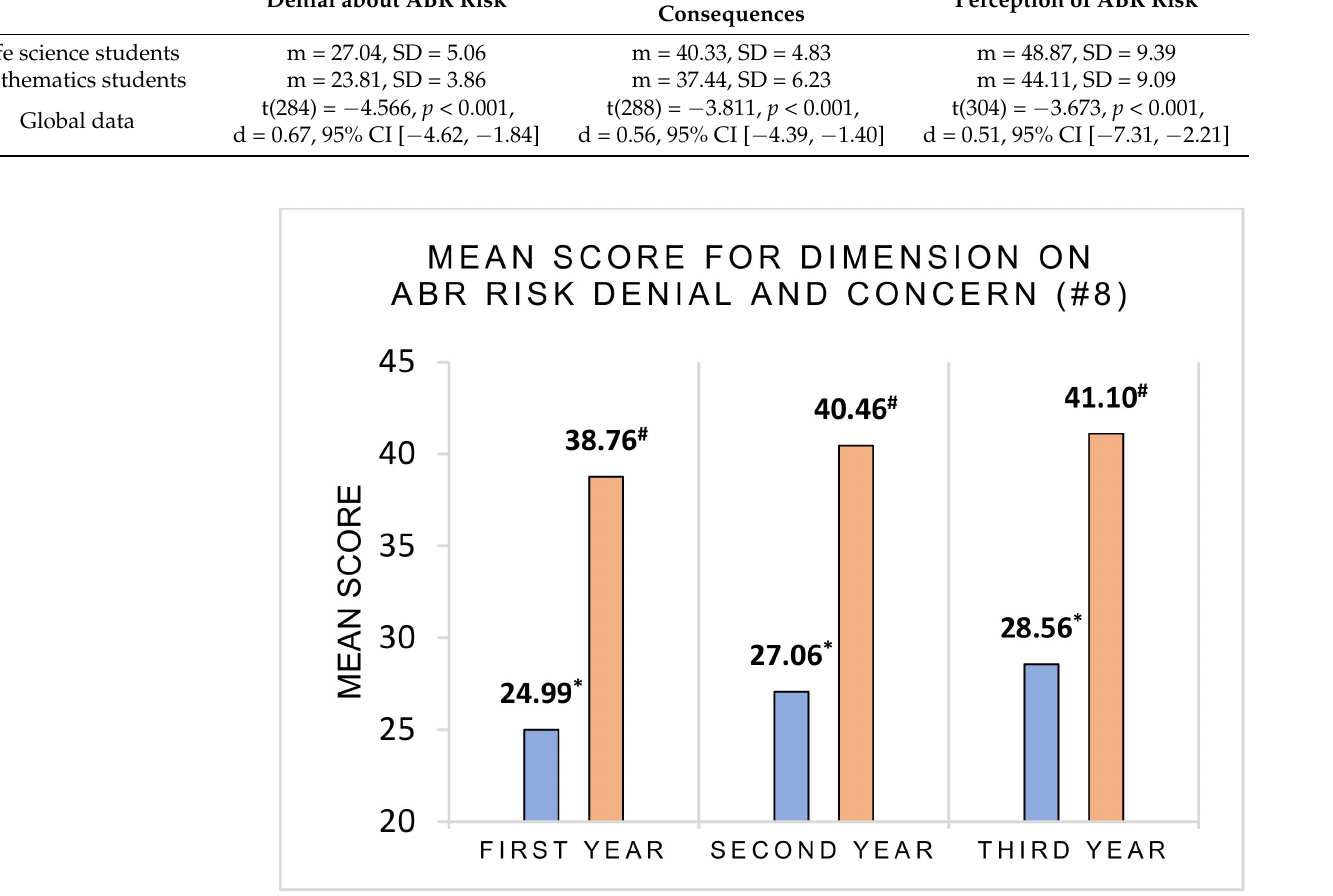
Figure 5. Expression of denial and health consequences for ABR risk depending on the year of study. The higher the score is, the lower the denial of the ABR risk and the higher the concern for health consequences of ABR risk. * Score is the sum of the answers to the items 1, 4, 5, 6, 9, 11, 12, 13 of question #8. # Score is the sum of the answers to the items 2, 7, 8, 14, 18, 19 of question